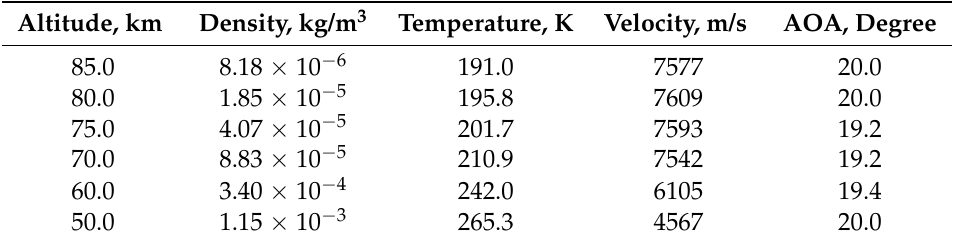
Table 1. Freestream parameters. AOA, angle of